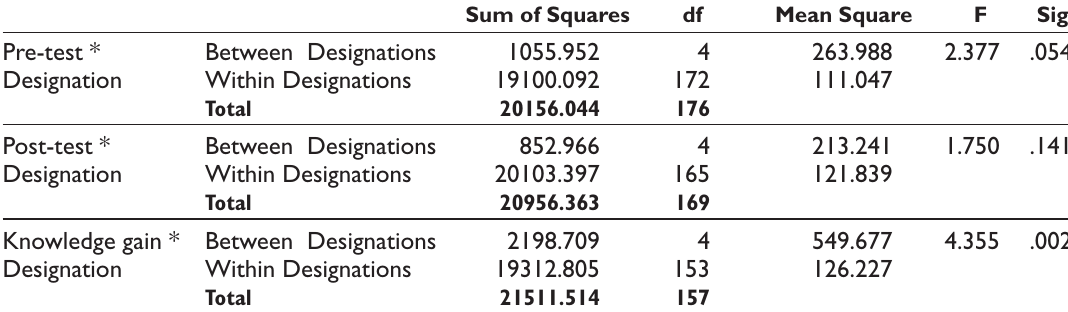
differences between post-test and pre-test scores were statistically significant (p<0.005) among the